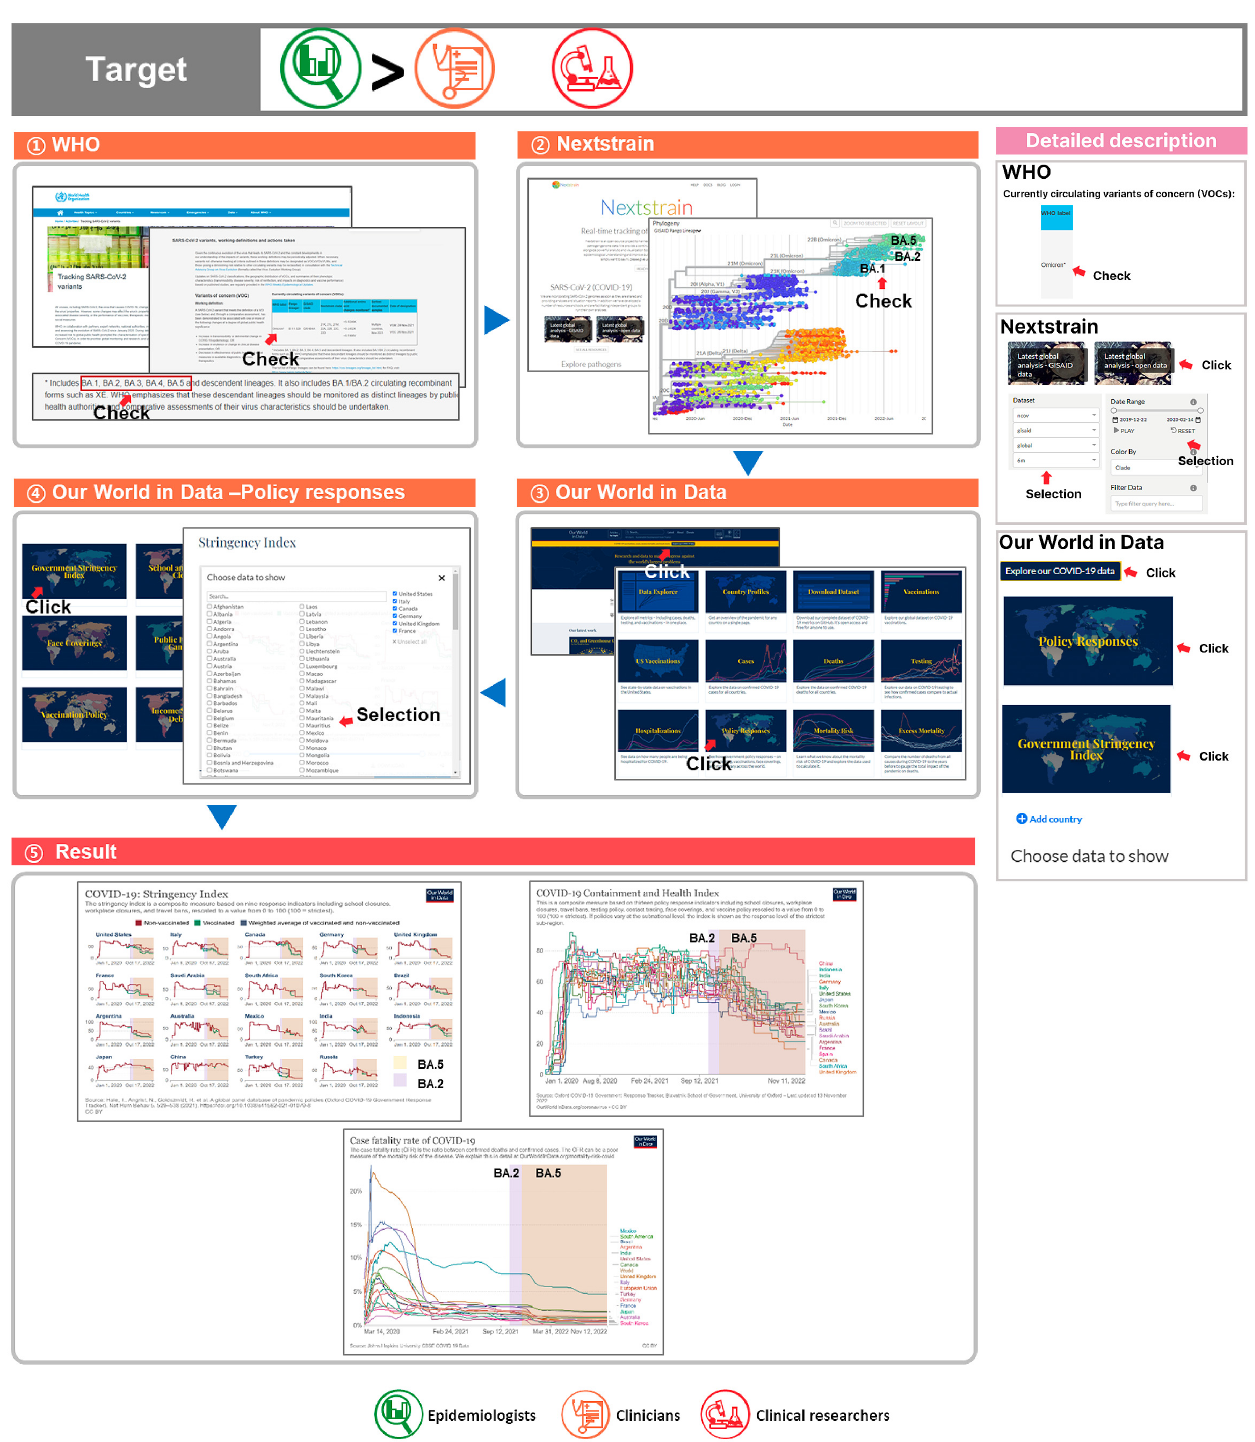
Figure 5. Comprehensive utilization of COVID-19 databases 4. Country policies and responses against SARS-CoV-2 variants were evaluated.